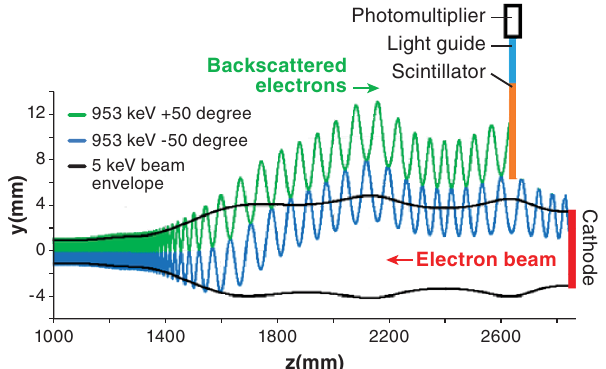
FIG. 4. Computer simulated trajectories (blue and green curves) of two scattered electrons generated inside of the 6 T solenoid (see text). Only the first 200 mm of this 2400 mm long superconducting solenoid is included at the left (from Z ¼ 1000 mm to Z ¼ 1200 mm). Three weaker solenoids (not shown) guide the electron beam from the cathode towards the 6 T region (see Fig.